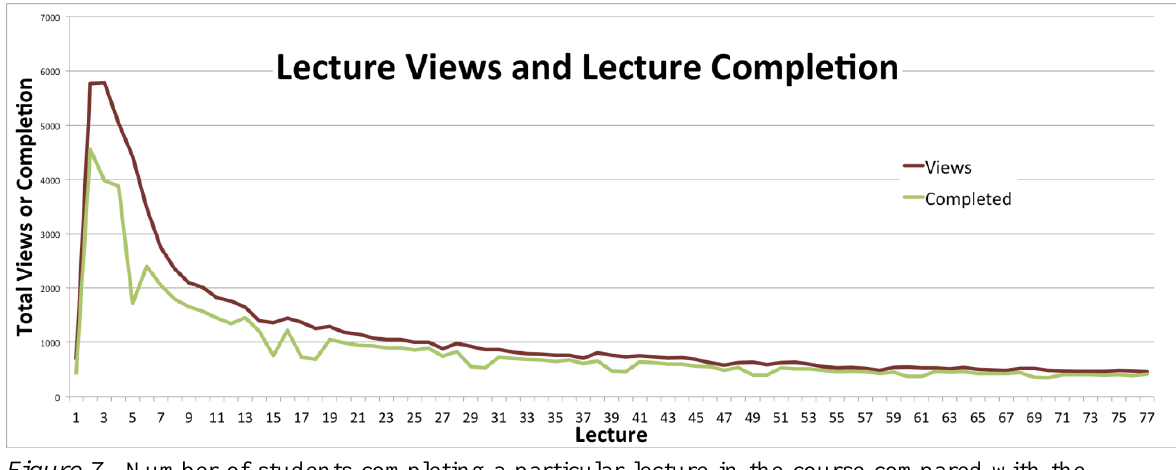
Figure 7. Number of students completing a particular lecture in the course compared with the number of students viewing or partially completing a lecture. Most of the lectures are short (8 to 12 minutes) videos but Udemy lists slides and readings as lectures too, and the dips in completion at the end of each section of the class correspond to lower completion of the slides and readings than the videos. Persistence can be seen in the flattening off of participation and completion for people who progress through more than the first quarter of the